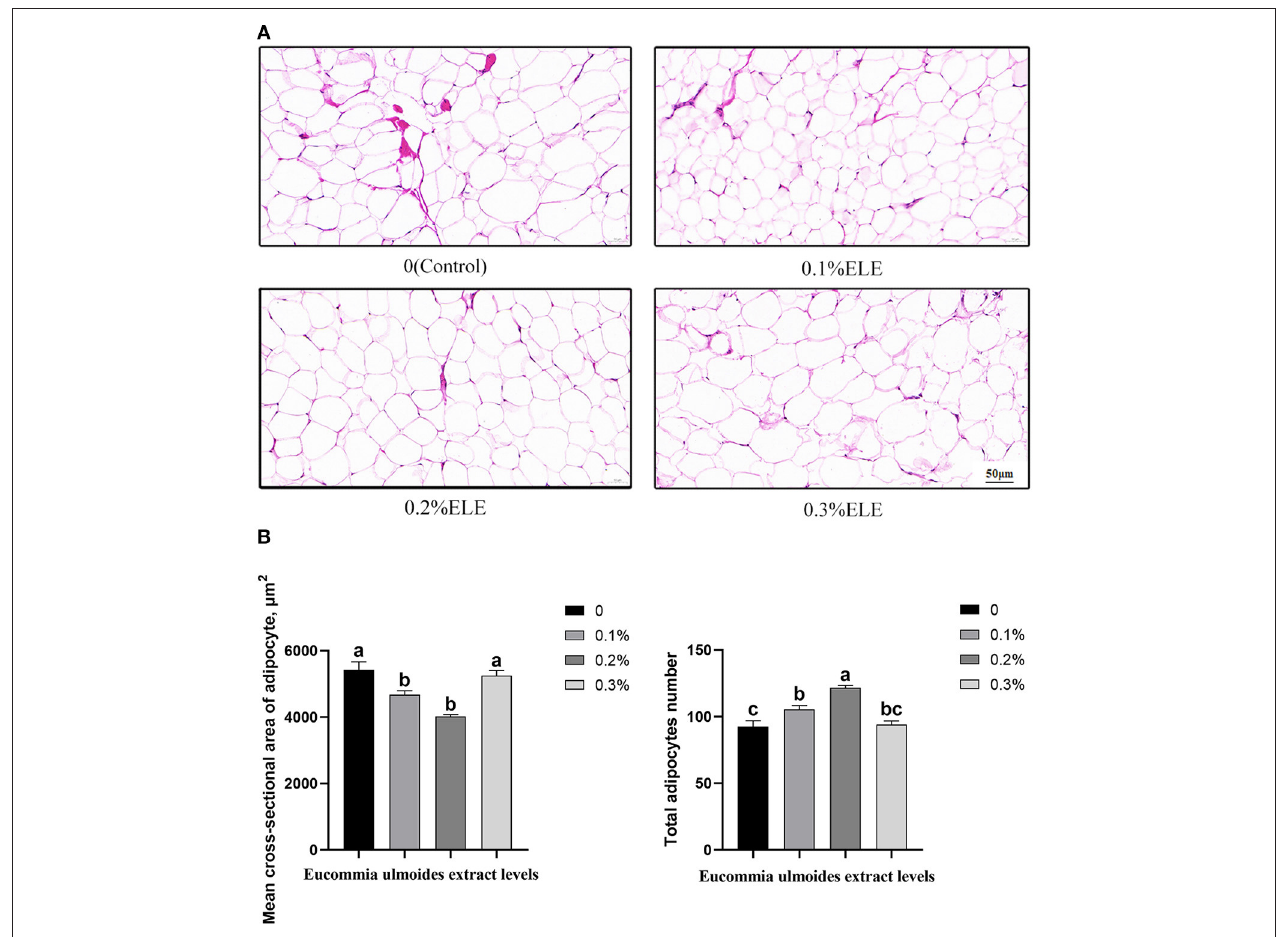
FIGURE 1 | Histological analysis of the mean cross-sectional area and quantity of adipocyte of growing–finishing pigs fed the diets of different levels of Eucommia ulmoides leaf extract (ELE). (A) Representative cross-sectional HE staining photos of adipocytes in backfat tissue (magnification × 100, bar = 50 µ m). (B) Quantitative analysis of adipocyte number in backfat tissue. Data are expressed as means ± SEM. a − c Values with different letters are significantly different among dietary ELE treatments ( p < 0.05) ( n =